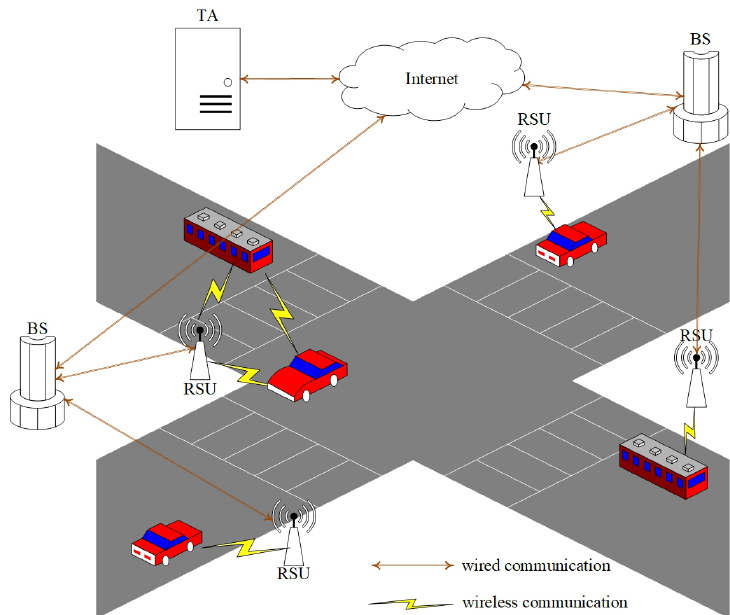
Figure 1. VANET architecture.